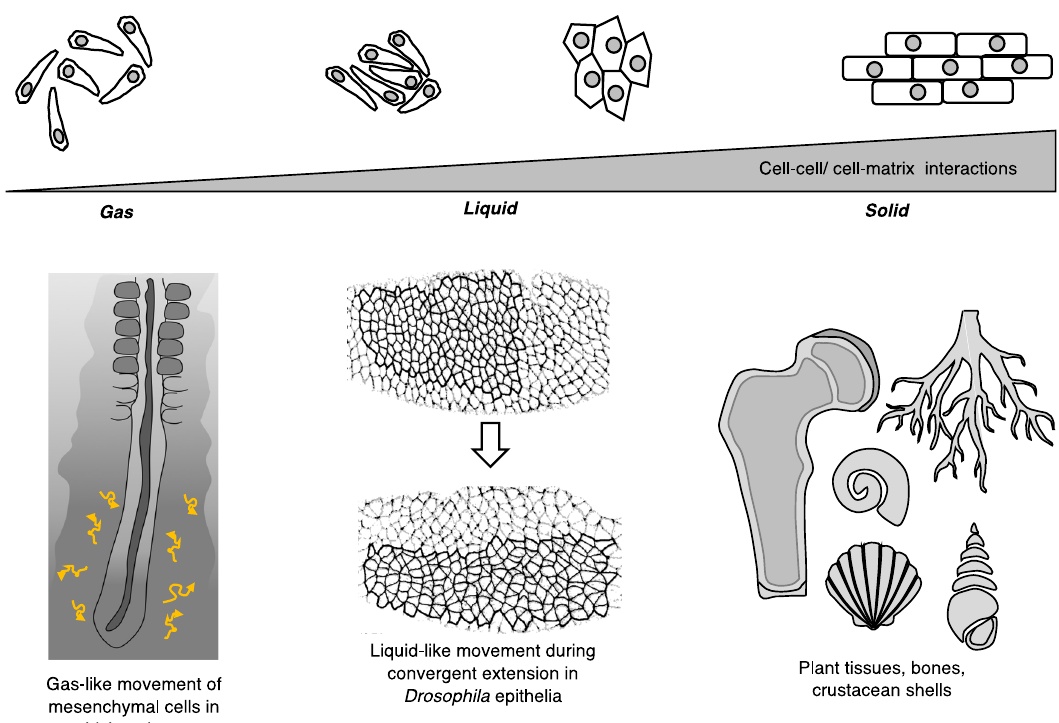
Fig. 1 Rich phenomenology of states of matter displayed by biological materials. Similar to physical matter, biological materials display both fl uid-like and solid-like properties at the population level, resulting from the interaction of cells with their neighbors and the extracellular media. State of tissue can be gas-like (e.g., mesenchymal cells in chick embryos, adapted from ref. 21 with permission from Nature ), liquid-like (e.g., epithelial tissue during gastrulation in Drosophila , adapted from ref. 112 with permission from Nature Cell Biology ) or solid-like (e.g., bones, cartilage, tree